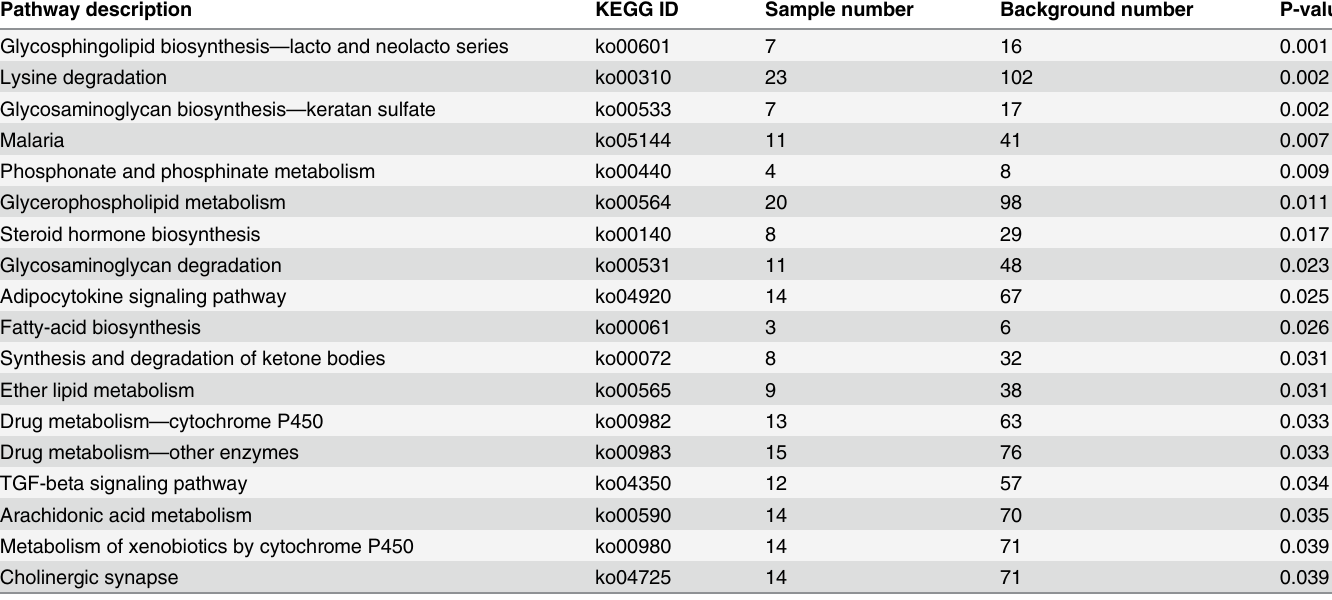
Table 6. Significantly changed KEGG pathways of L . vannamei between the two tested salinities.